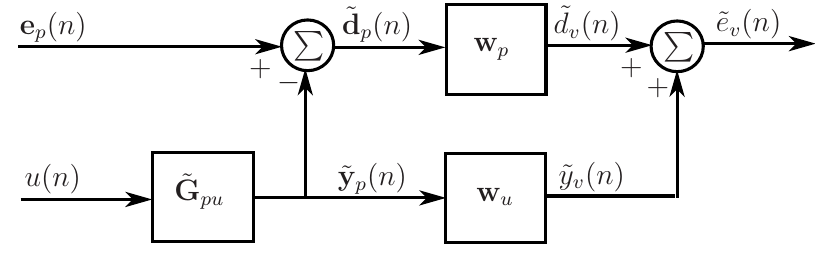
Figure 8 . Block diagram of the adaptive LMS virtual microphone technique